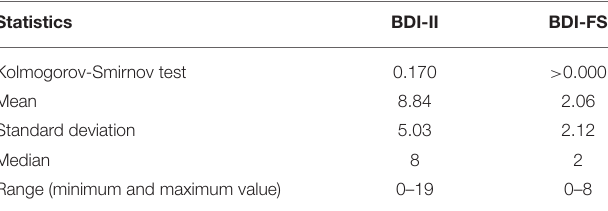
TABLE 2 | Descriptive statistics of the BDI-II and